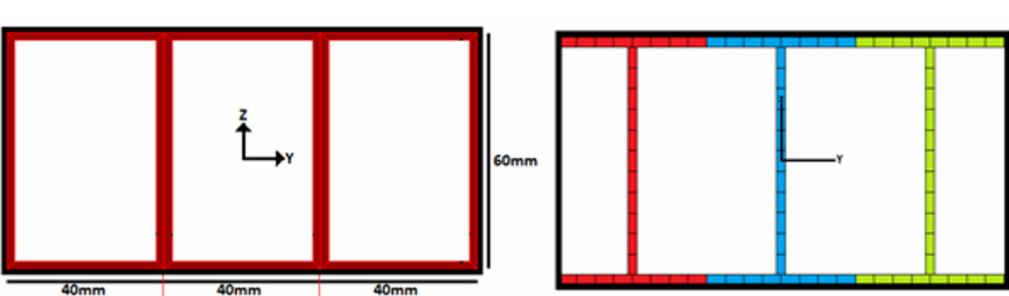
Figure 9. Multi-cell composite beams with rectangular and I-beam cross sections. Each of the single cells has the dimensions of the rectangular envelope (40 mm by 60